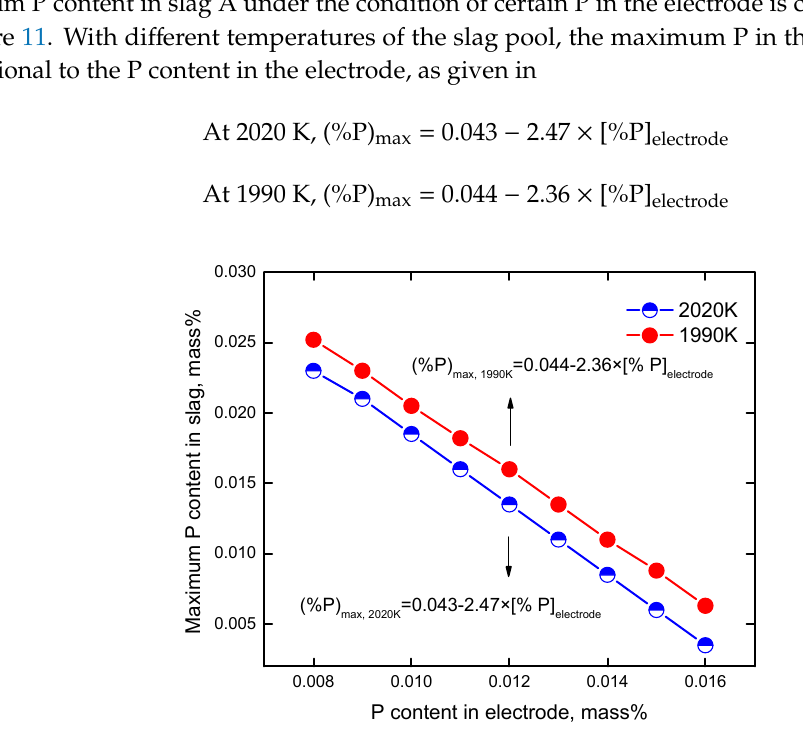
Figure 11. The corresponding maximum P content in slag A under certain P content in electrode, when the P content of the ingot is maintained at 0.015%.